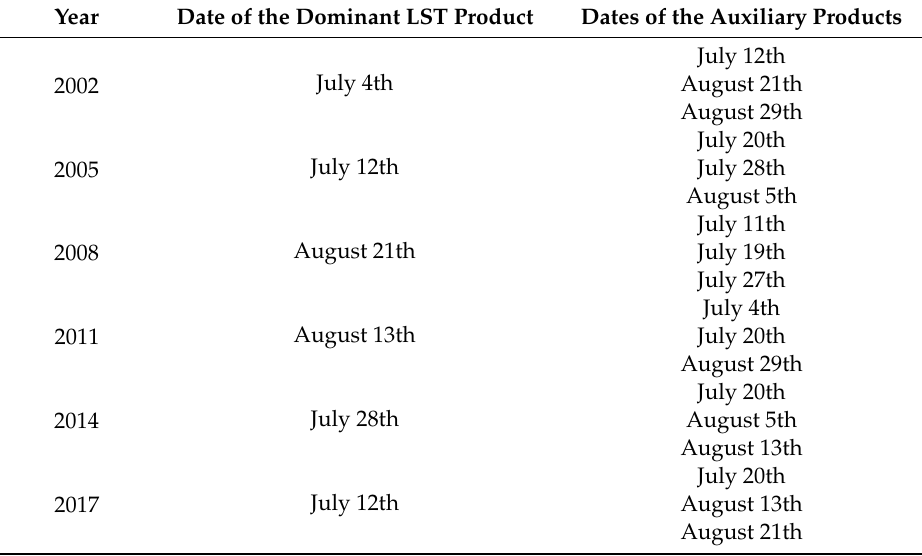
Table 1. The dates of LST products of each year in this